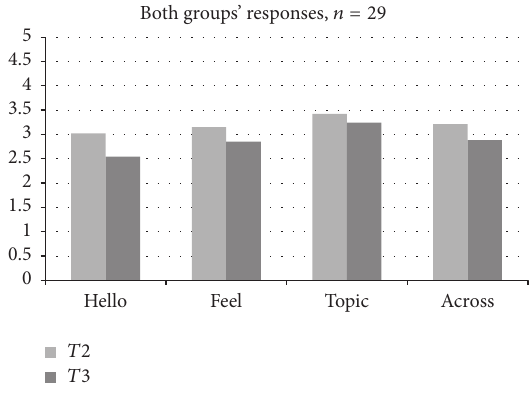
Figure 3: Combined responses across time